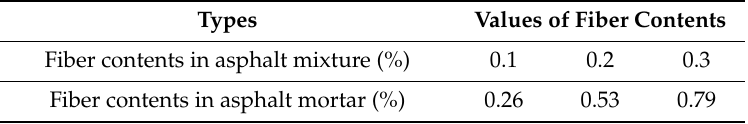
Table 5. Relationship of fiber contents between asphalt mixture and corresponding